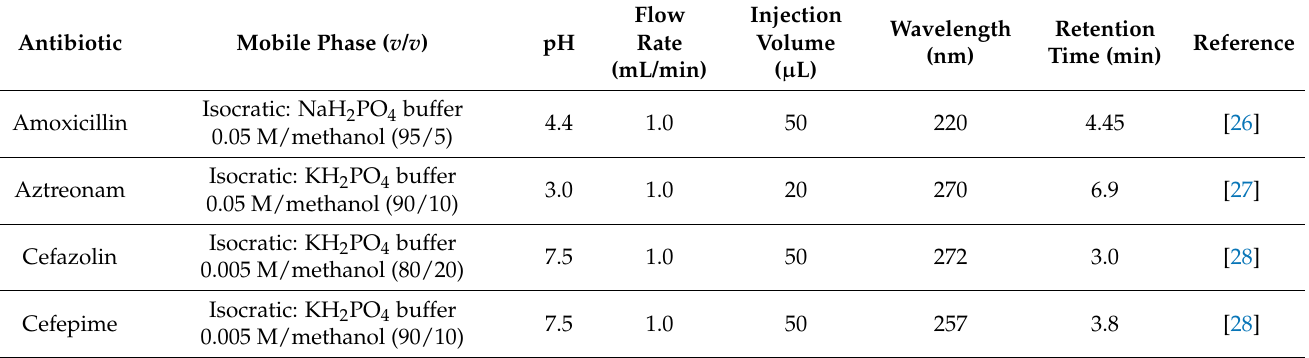
Table 6. List of HPLC conditions for the antibiotic stability